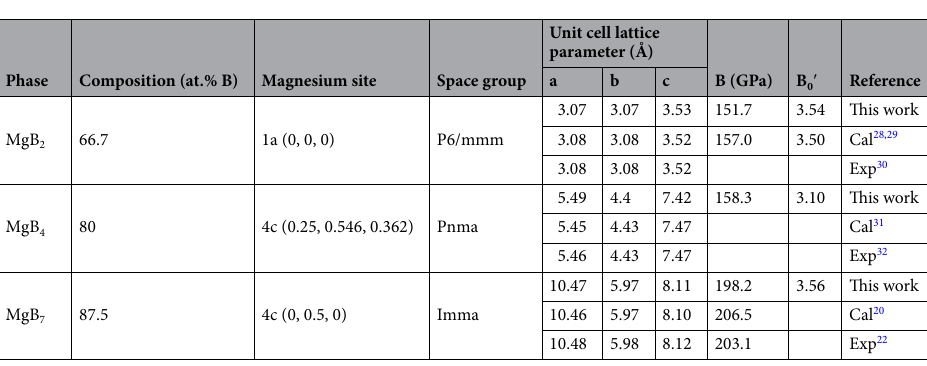
Phase Composition (at.% B) Magnesium